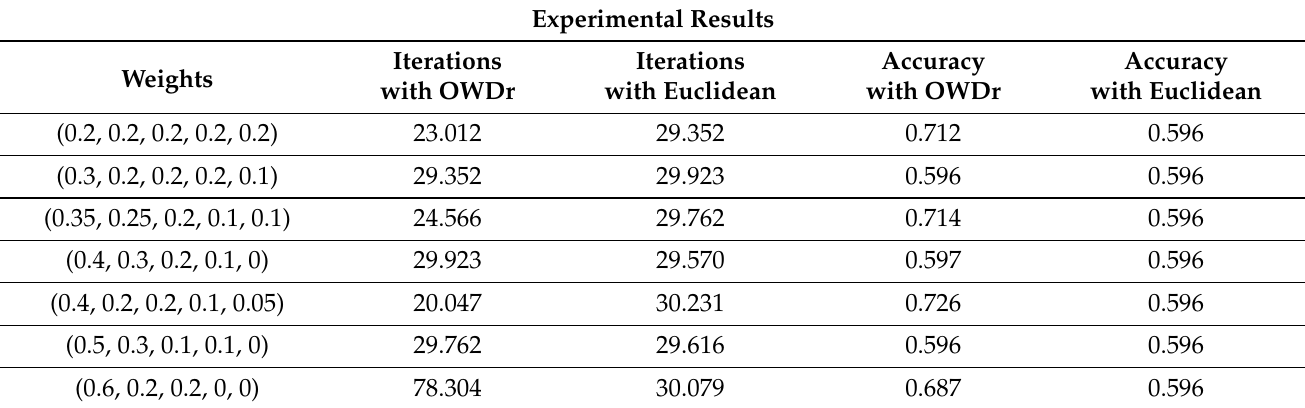
Table 3. Accuracy and iterations (both as averages) needed to convergence for K-means (Euclidean) and OWA-based K-means (OWDr) after 1500 experiments.